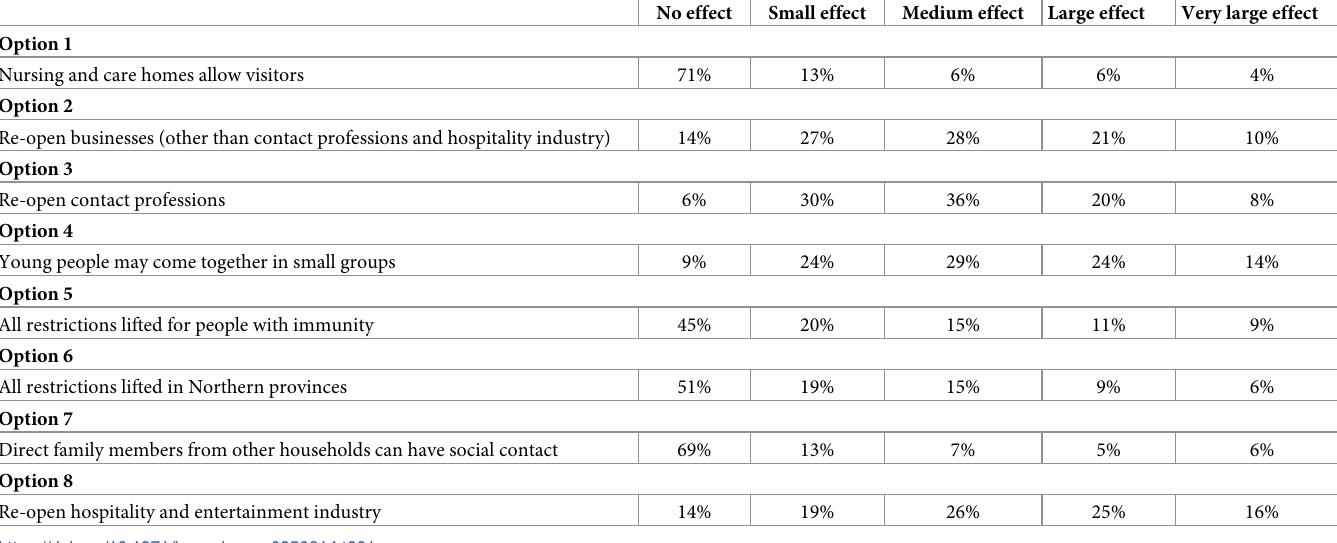
Table 1. To what extent will lifting lockdown measures have an effect on your